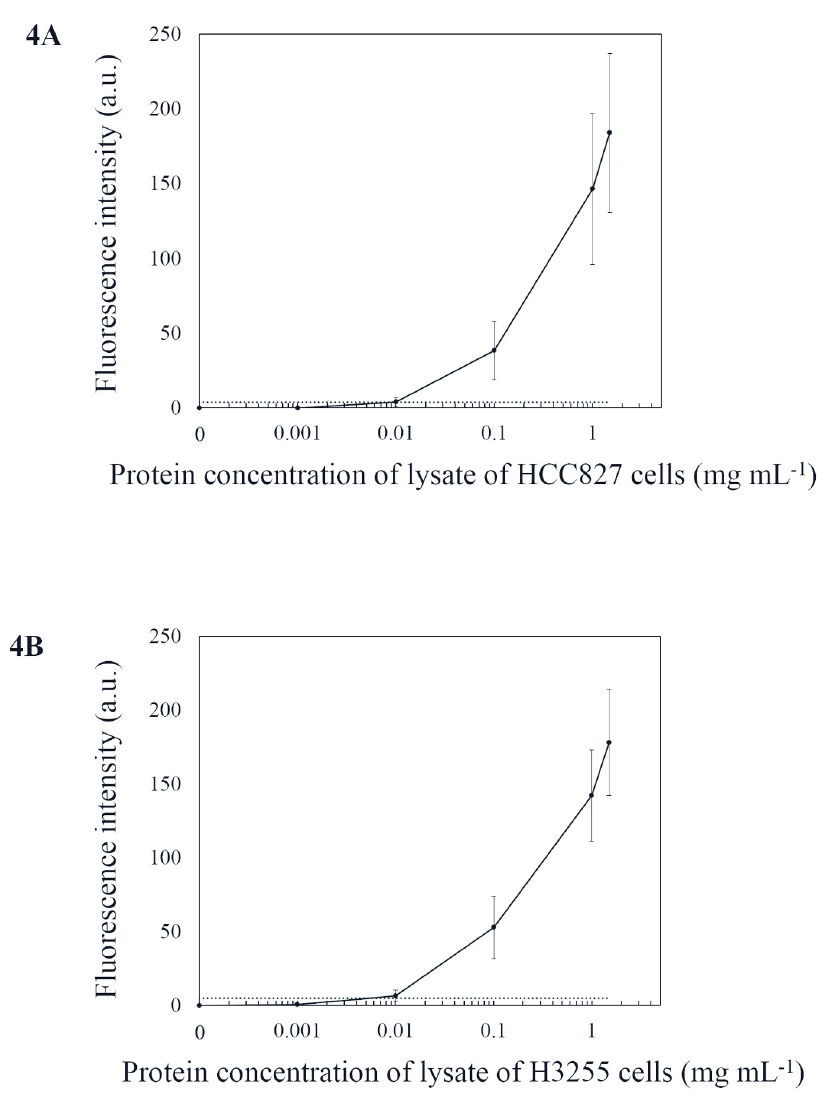
Fig 4. Calibration curves derived from total protein concentration in mutant EGFR cell lines versus device fluorescence intensity. The dashed lines indicate fluorescence values three standard deviations above the average for the EGFR WT cell line (H358) detected in each immuno-wall